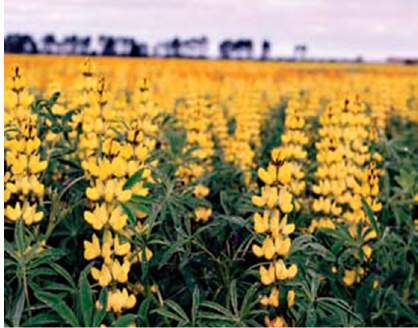
Figure 4 . Lupinus luteus (Yellow lupin) Photo: P. White